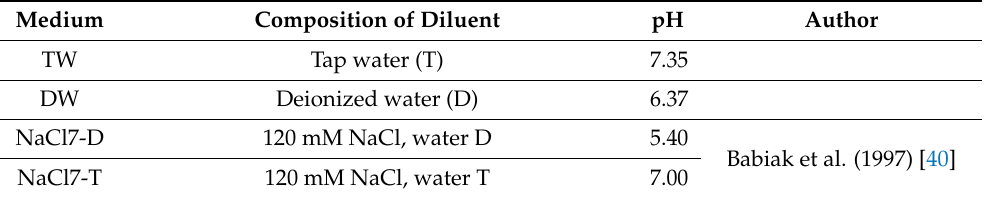
Table 2. The composition and pH of different activating media in Experiment No. 2 for northern pike ( Esox lucius ) gametes. pH was measured during these studies. The “Author” column presents the authors of the work, the year of publication, and the reference